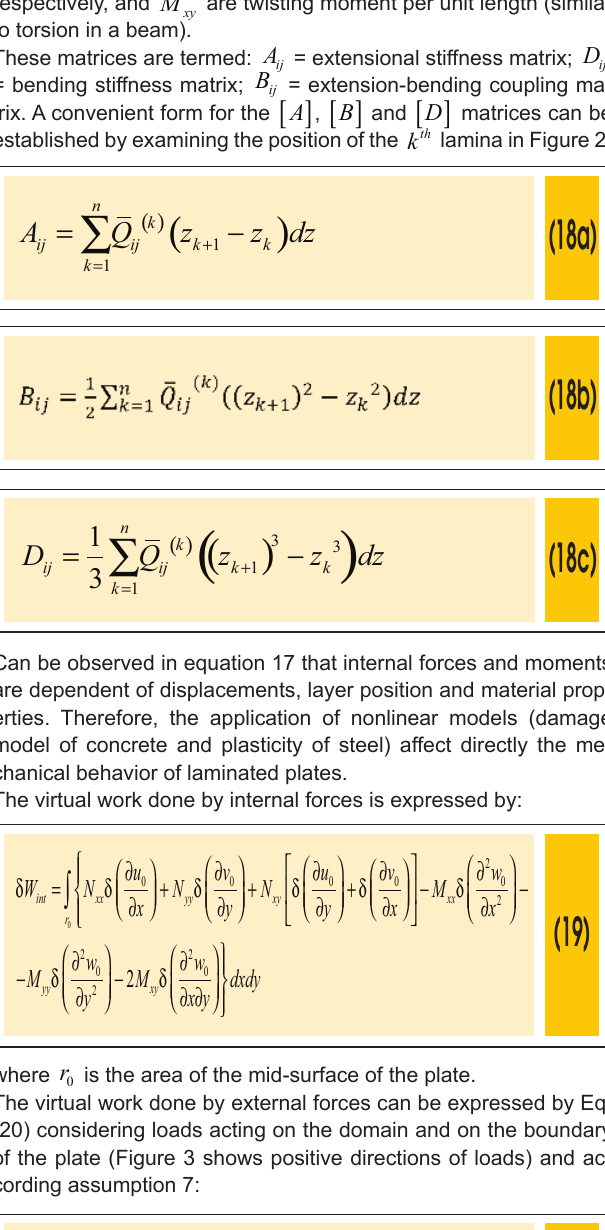
Figure 3 – Forces and moment resultants on a plate